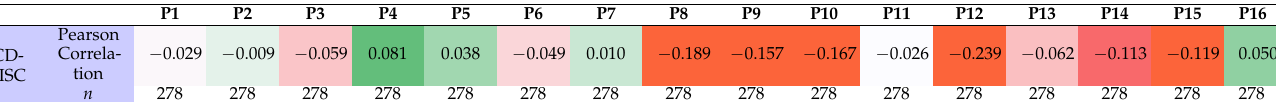
3. Correlation between personal/individual resilience and frequency of different coping